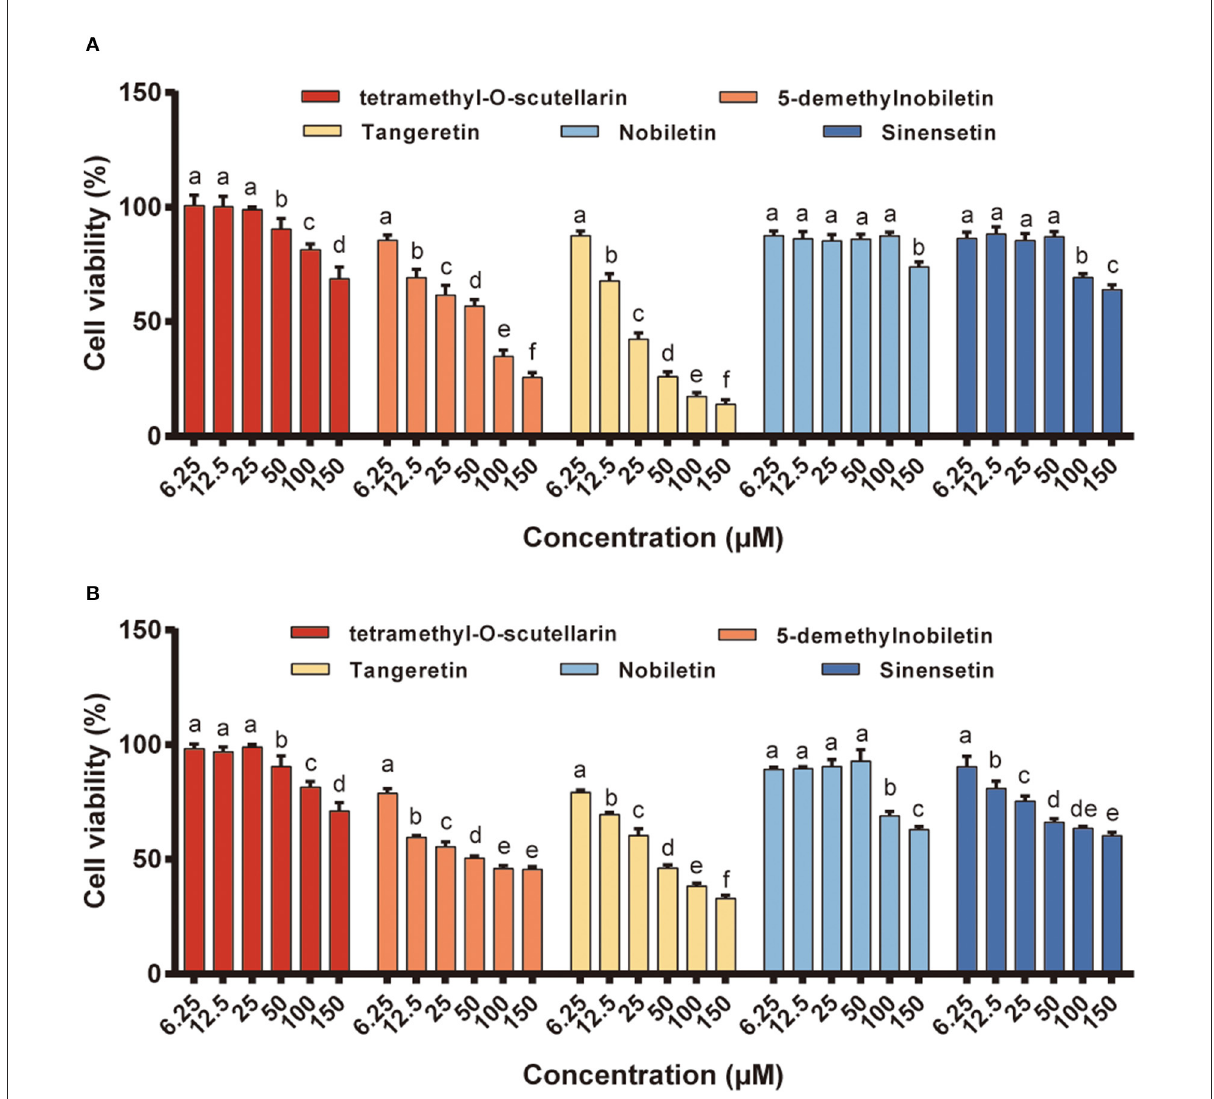
FIGURE5 The anti-proliferation activity of different PMFs against two prostate cancer cell lines. (A) PC-3; (B) DU145. Results were expressed as the means ± SD, n = 3 experiments. Means denoted by different lower-case letters are significantly different (One-way ANOVA, Dunnett’s post-hoc test, p <